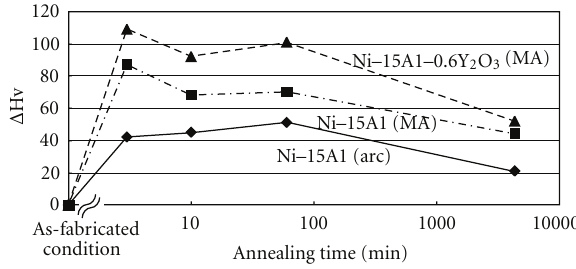
Figure 2: Hardness increase Δ Hv during aging at 800 ◦ C.